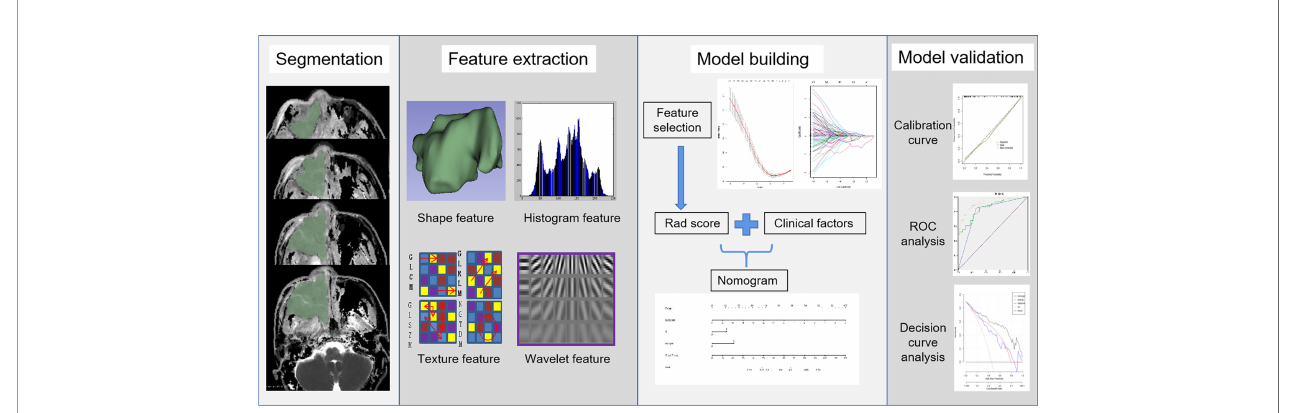
FIGURE 1 | Flowchart of radiomics for predicting the risk of ER in this